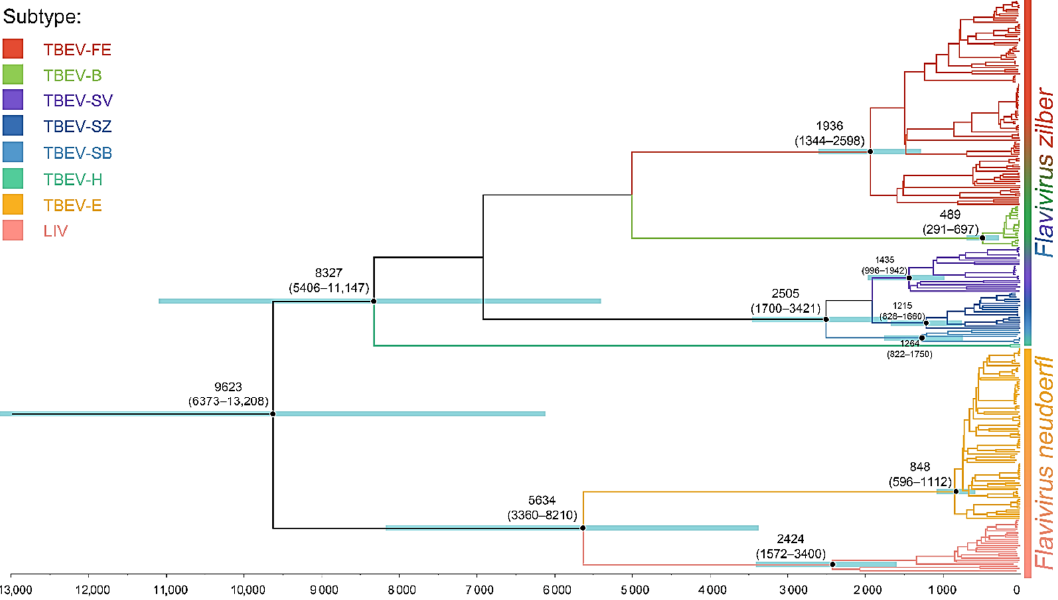
Figure 4. Maximum clade credibility tree of tick ‐ borne encephalitis virus (TBEV) aggregated by FigTree from trees produced by an MCMC run. Horizontal bars are 95% highest posterior probability density (HPD) intervals. Numbers above main nodes indicate divergence times before the most recent sample collection (2 June 2021) with 95% HPD in parenthesis. All nodes dated on the tree have a posterior probability of 1.0.